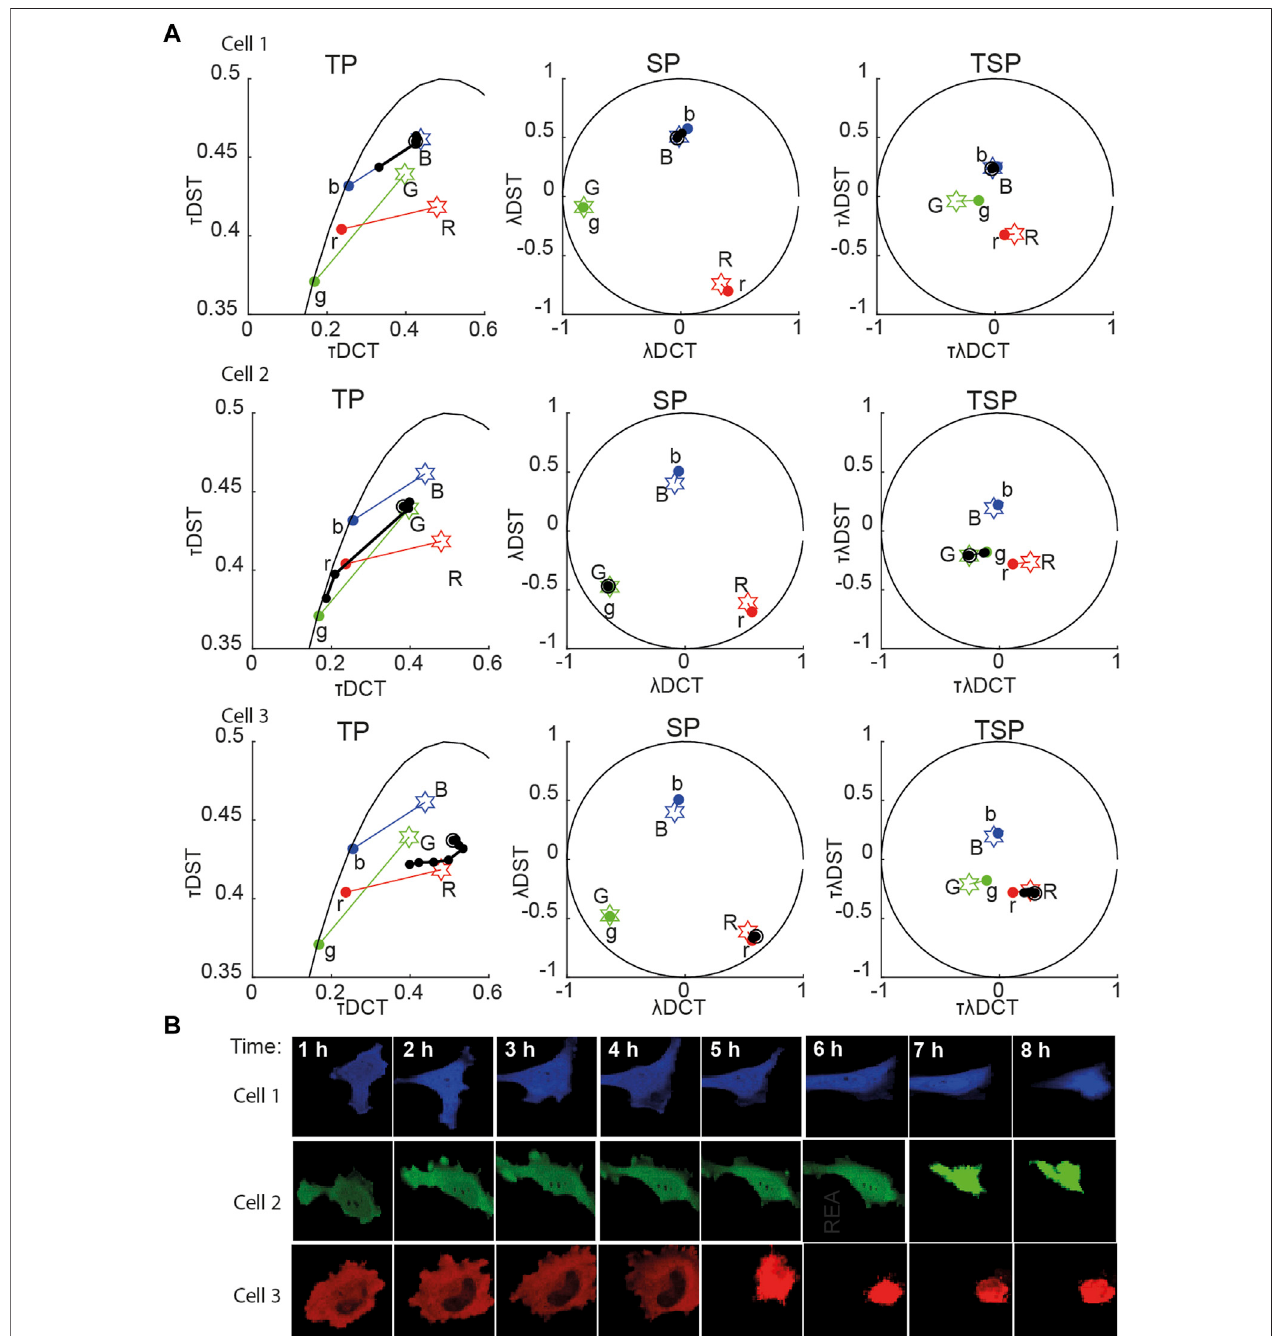
FIGURE 2 | Multidimensional phasor representation of time-lapse sFLIM of single FRET pairs. (A) Multidimensional phasor transforms (here, only TP, SP, and TSP are shown) of the representative cells expressing blue-only sensor (top row, cell 1), green-only sensor (middle row, cell 2), and red-only sensor (bottom row, cell 3). Cells were treated with cisplatin and imaged for 8 h. The black circles (experimental measurements taken every hour) and lines represent the biochemical trajectory of a cell projected on the different phasor spaces that should span from the negative control fi ngerprints (stars labeled B , G , and R , uncleavable sensors) to the donor- onlyreferences(coloredcircleslabeled b , g ,and r ). (B) Intensityimages(totalphoton-counts/pixelofsFLIMimages)ofthecellsanalyzedin (A) .Inpanel (A ),DCT-discrete cosine transform, DST-discrete sine transform; λ -marks spectral domain or spectral transformation ( λ DCT/ λ DST); τ -marks time-domain or time phasor transformation ( τ DCT/ τ